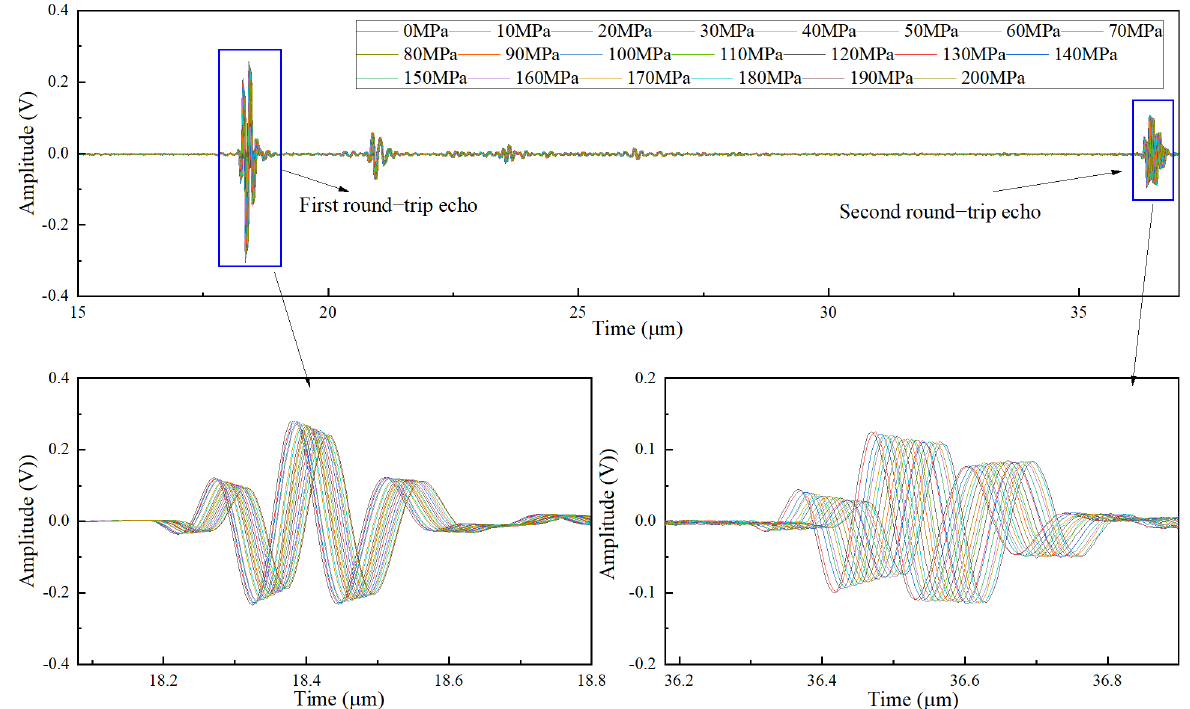
Figure 7. The echo signals under 20 steps of axial preload for the clamping length of 35.70 mm. Rectangular windows were used to extract the first and second round-trip echo sig-